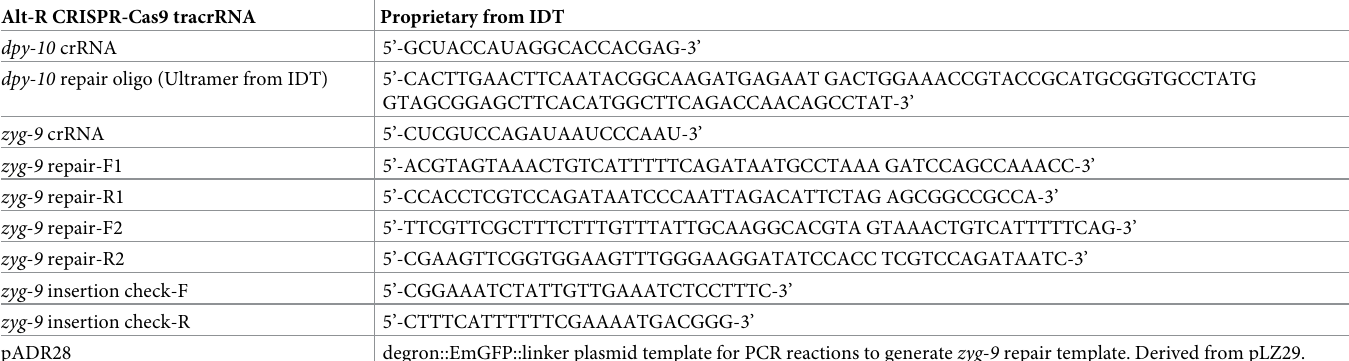
Table 2. CRISPR/Cas9